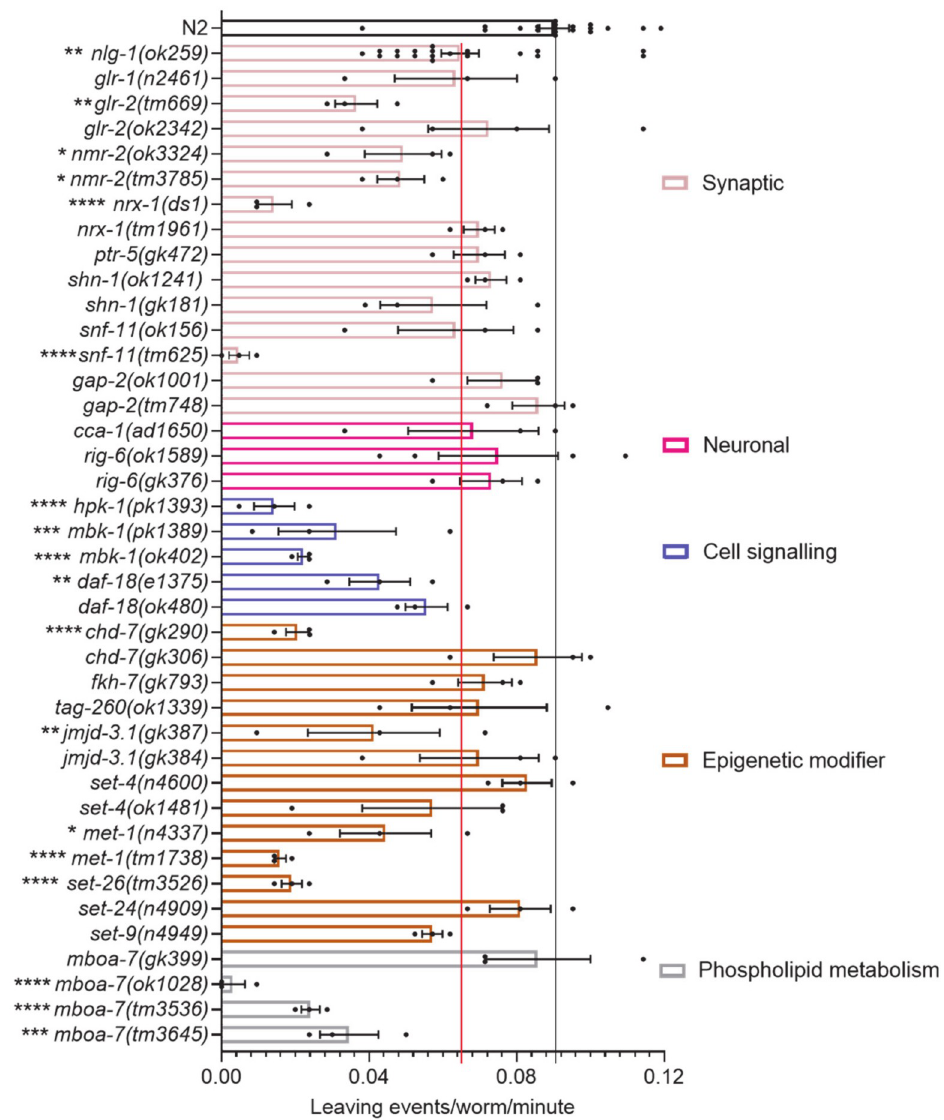
Fig 2. Food leaving behaviour of C . elegans mutants after 24 hours on food to investigate human ASD associated genes. A food leaving assay was performed with N2, nlg-1(ok259) and 39 other C . elegans mutants. Genes are categorised and colour coded into different functional domains. The black line indicates the number of leaving events/ worm/minute for N2 control. The red line indicates the food leaving rate of nlg-1(ok259) control. N2 and nlg-1(ok259) n = 19. All other mutants n = 3–4, where n refers to the number of replicates of an individual experiment. Strains were screened in batches across different days. Each batch consisted of 4–6 mutant strains and a paired wild-type control. Data plotted includes all wild-type controls. All data shown as mean ± SEM. Statistical analysis performed using a one- way ANOVA and Dunnetts’s multiple comparison test; ns, p > 0.05; � , p < 0.05; �� , p p � 0.01; ��� , p � 0.001; ���� , p � 0.0001. All significance relates to a comparison with N2